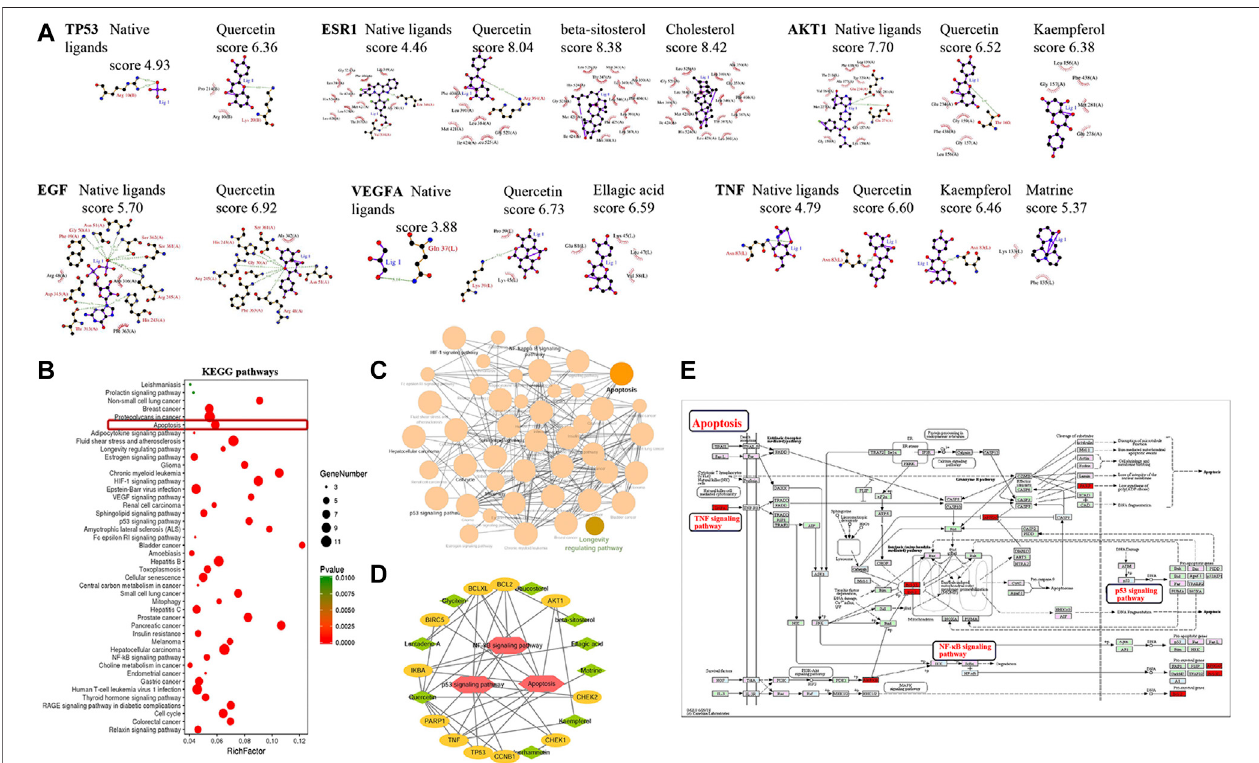
FIGURE 3 | Molecular docking and KEGG pathway analysis of the targets. (A) Molecular docking of the hub targets and related bioactive components. The interactive hub targets (TP 53, AKT1, VEGFA, ESR1, EGF, and TNF) and their related ingredients or native ligands were analyzed using molecular docking, a higher dockingscore indicates stronger binding. (B) Bubble chart ofthe targets enriched KEGG pathways. Thebubble sizerepresents thenumber ofthe target in the enriched pathway terms, bubble color representsthe pathway ’ s p value. The apoptosis pathway was founded tohave ahigh number oftargets enriched and a signi fi cant p value. (C) KEGG pathway network of the targets. Different nodes represent different pathways, these pathways interact with each other and form a pathway network. Theapoptosis pathway interactswithmultiplepathways. (D) Pathway-target-ingredientnetwork.Thered polygon represents thepathway,